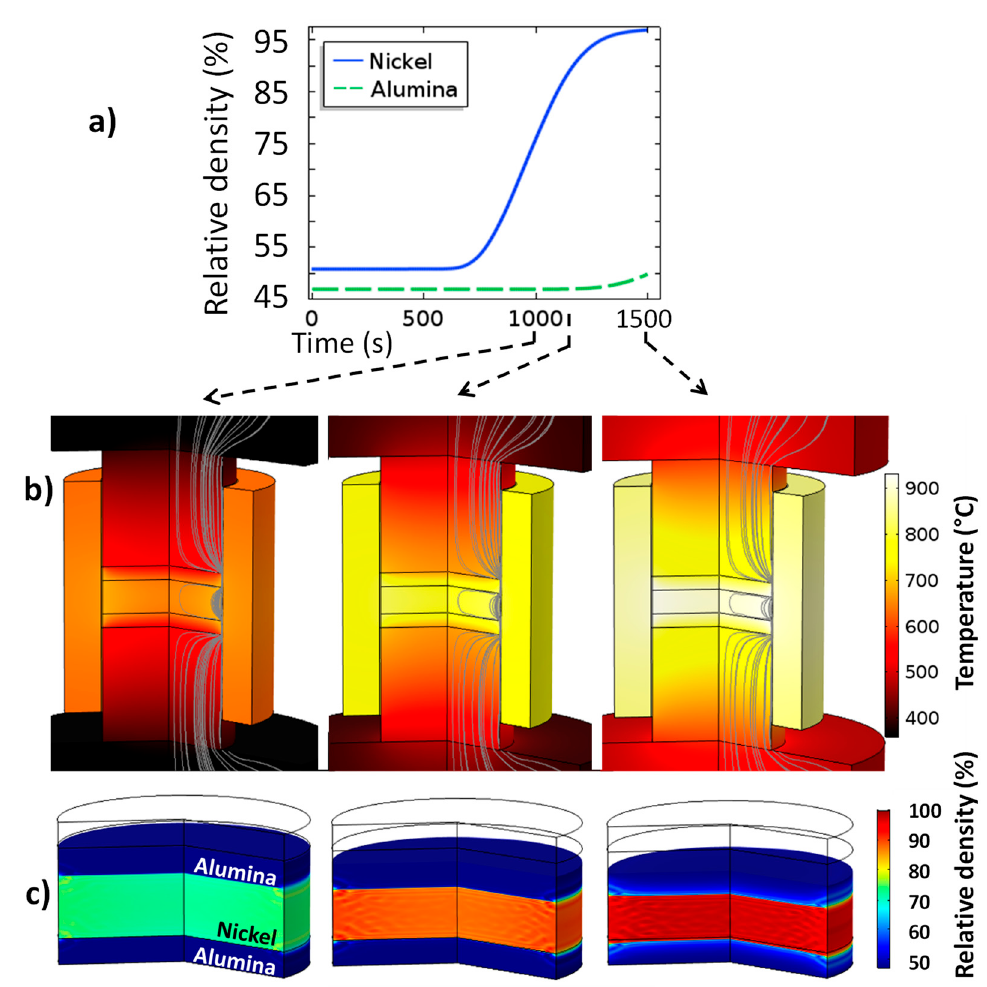
Figure 5. Electrothermal-mechanical simulation results, within the upper part ( a ), the mean densification curves for the alumina and nickel powders and, in the lower part, ( b ) the simulated temperatures, electric current lines, and ( c ) sample relative density fields at 1000, 1150, and 1500 s.